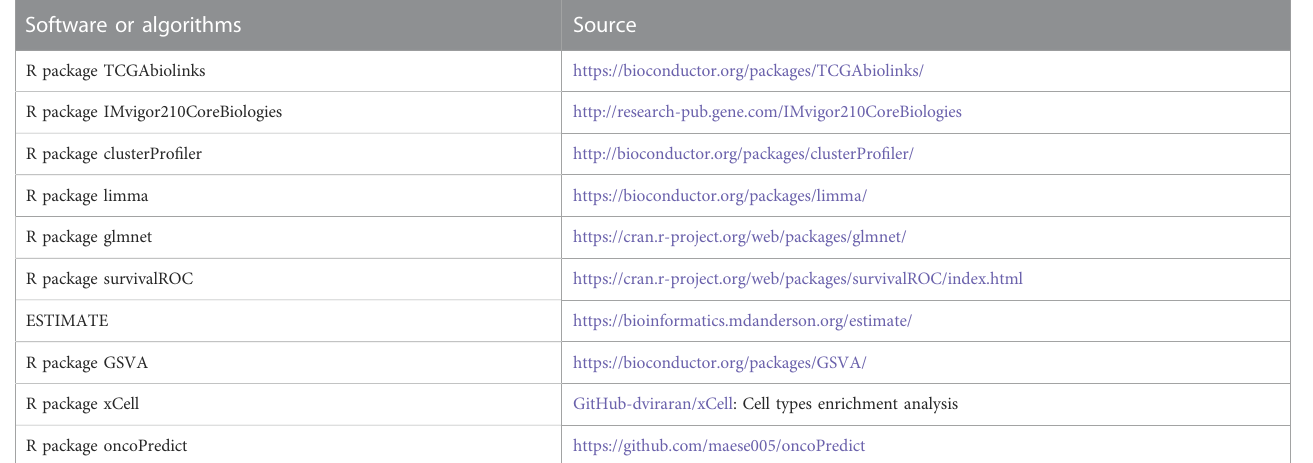
TABLE 2 Key resources table-Software and algorithms. Software or